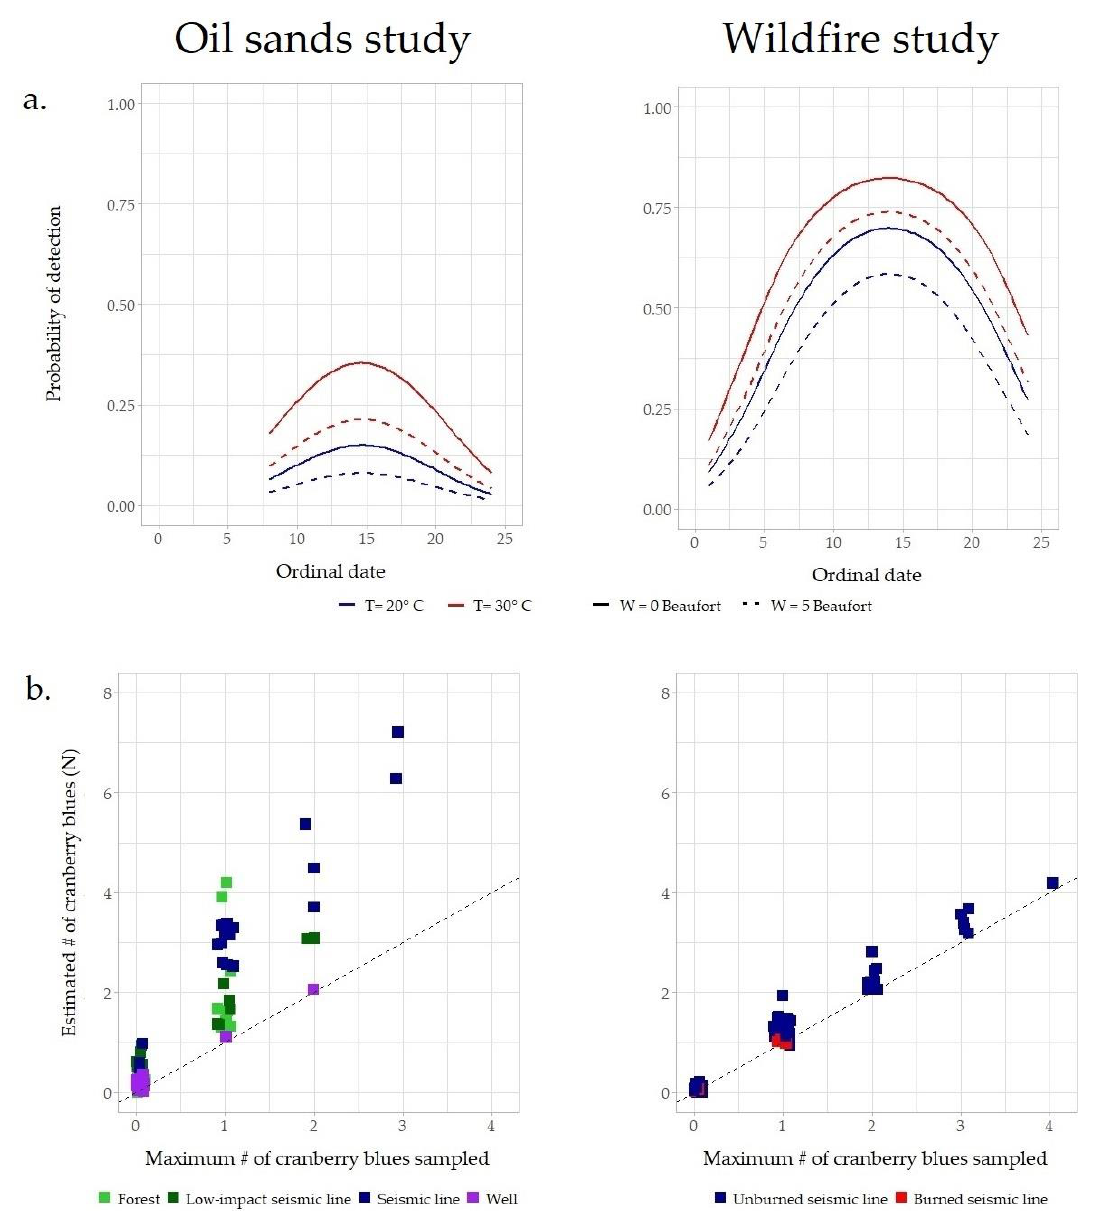
Figure 3. ( a ) Detection probability (y axis) as a function of ordinal day (x axis; 22nd June = 1), temperature (line color), and wind (line type). Both studies suggest that cranberry blue detectability peaks around 5th July (14th ordinal day), with a negative effect of wind and a positive effect of temperature, and a flight curve lasting approximately four weeks. ( b ) Predicted abundance ( N i ; y axis) at each point-count location vs. highest number of cranberry blues observed at each point-count location ( y i max; x axis). Colors represent the treatments included in the experimental design (oil sands study: N = 120 point-counts stratified in control forests, low-impact seismic lines, conventional seismic lines and well pads; wildfire study: N = 200 point-counts stratified in burned and unburned seismic lines). Note that a lower probability of detection (oil sands study) entails a larger difference between the cranberry blues observed at a site and the predicted abundance of cranberry blues.